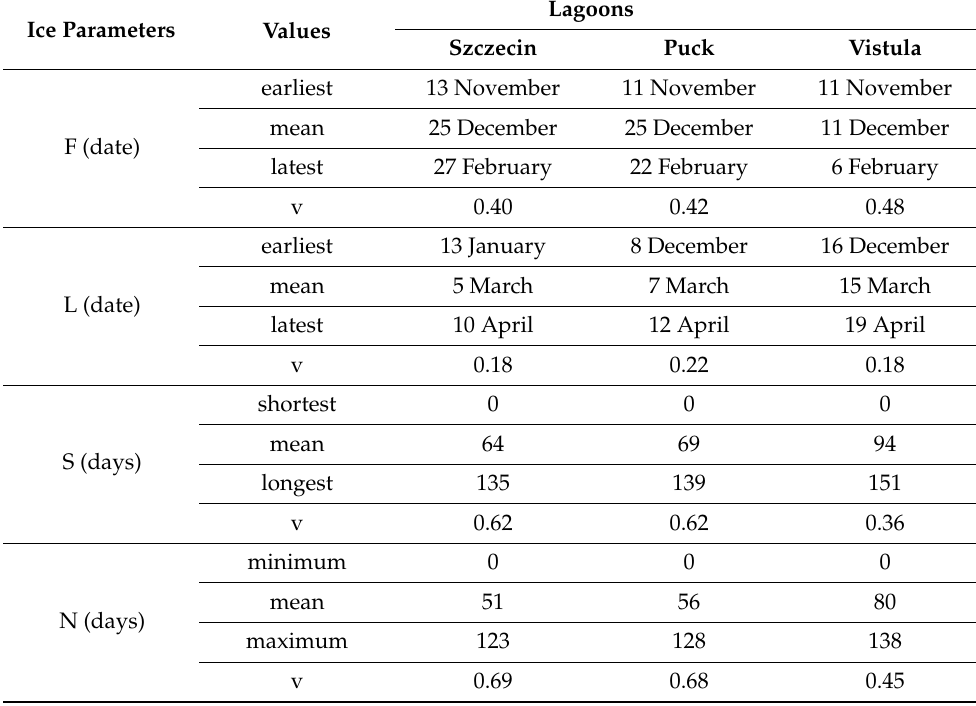
Table 2. Means and extreme values and coefficients of variability (v) of ice parameters: date of first ice occurence (F), date of last ice disappearance (L), number of days with ice (N), duration of ice season (S), maximum ice thickness (H) in southern Baltic coastal lagoons (1950/51–2019/20). Lagoons Ice Parameters Values Szczecin Puck